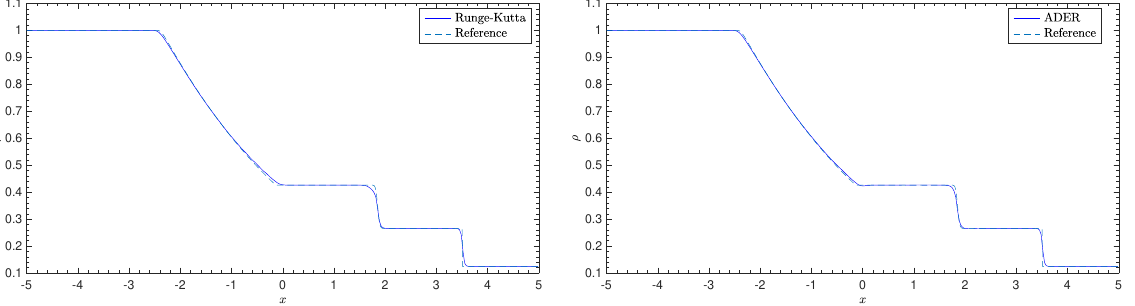
Figure 10. Computed density variable ρ for the problem (63) (Euler equations) with the fourth-order well-balanced Runge–Kutta ( left ) and ADER ( right ) numerical methods at time t = 2 s. An uniform Cartesian mesh of N x = 300 elements has been used.